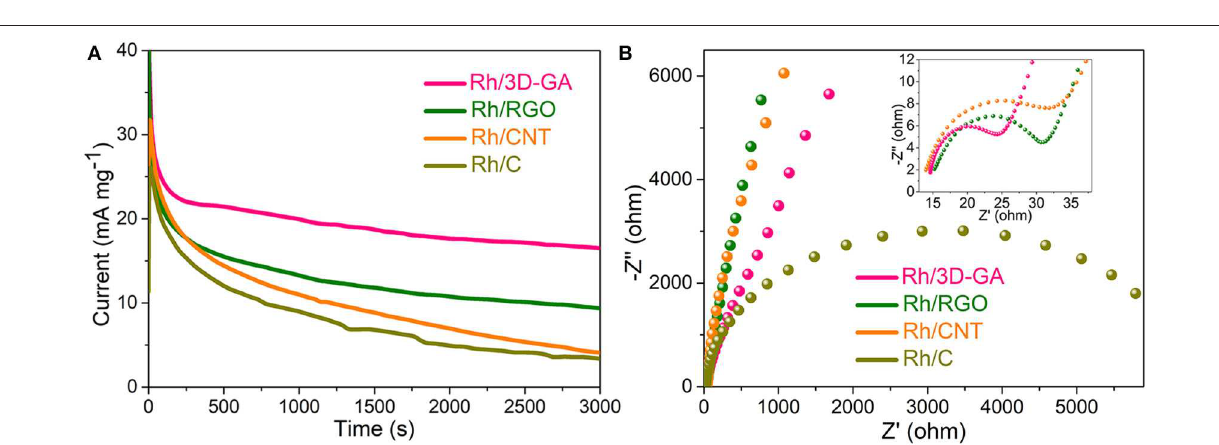
discloses that Rh/3D-GA possesses well-defined 3D cross-linked